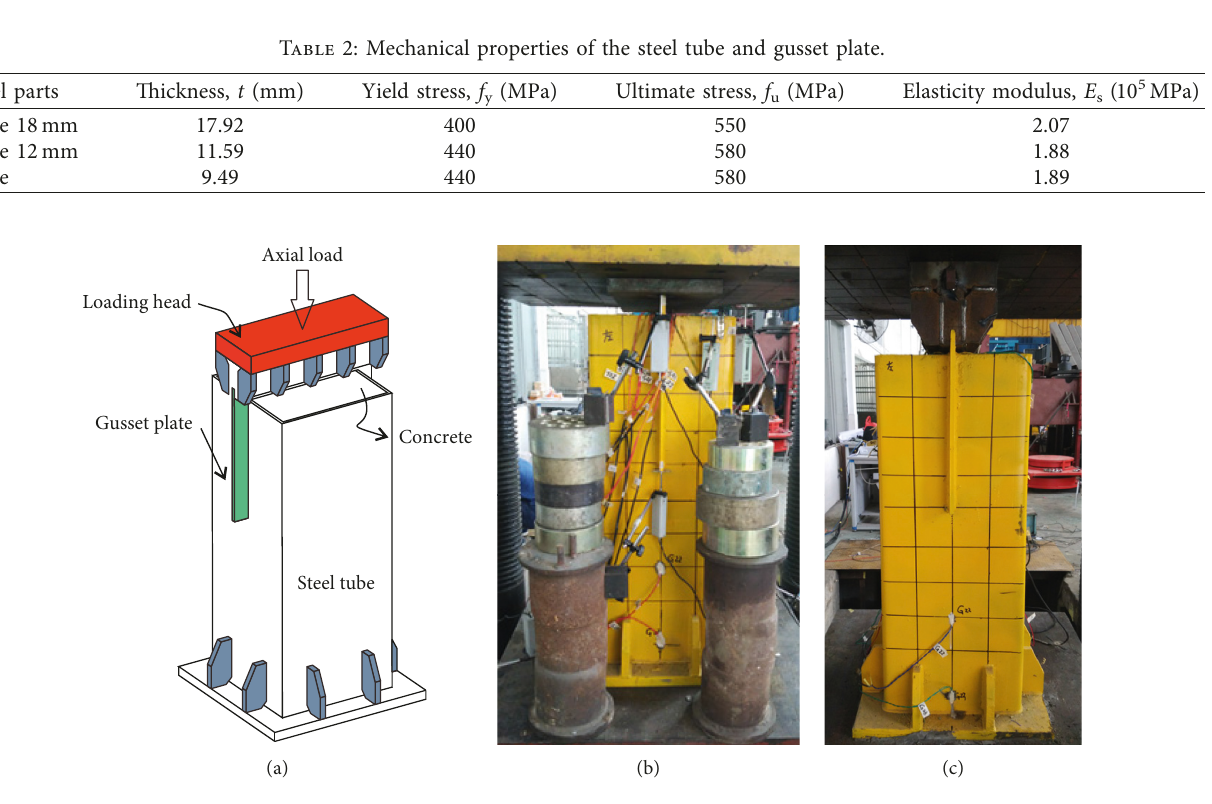
Figure 2: Experimental setup: (a) schematic diagram of the experiment, (b) flat loading head, and (c) stiffened loading